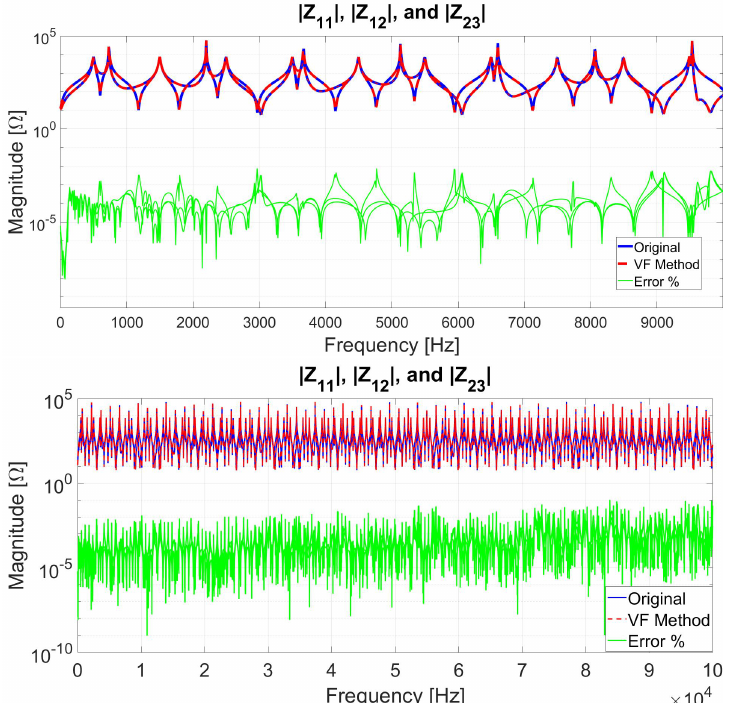
Figure 23. The magnitude of the measured and fitted impedance using VF, | Z 11 | , | Z 12 | , and | Z 23 | .